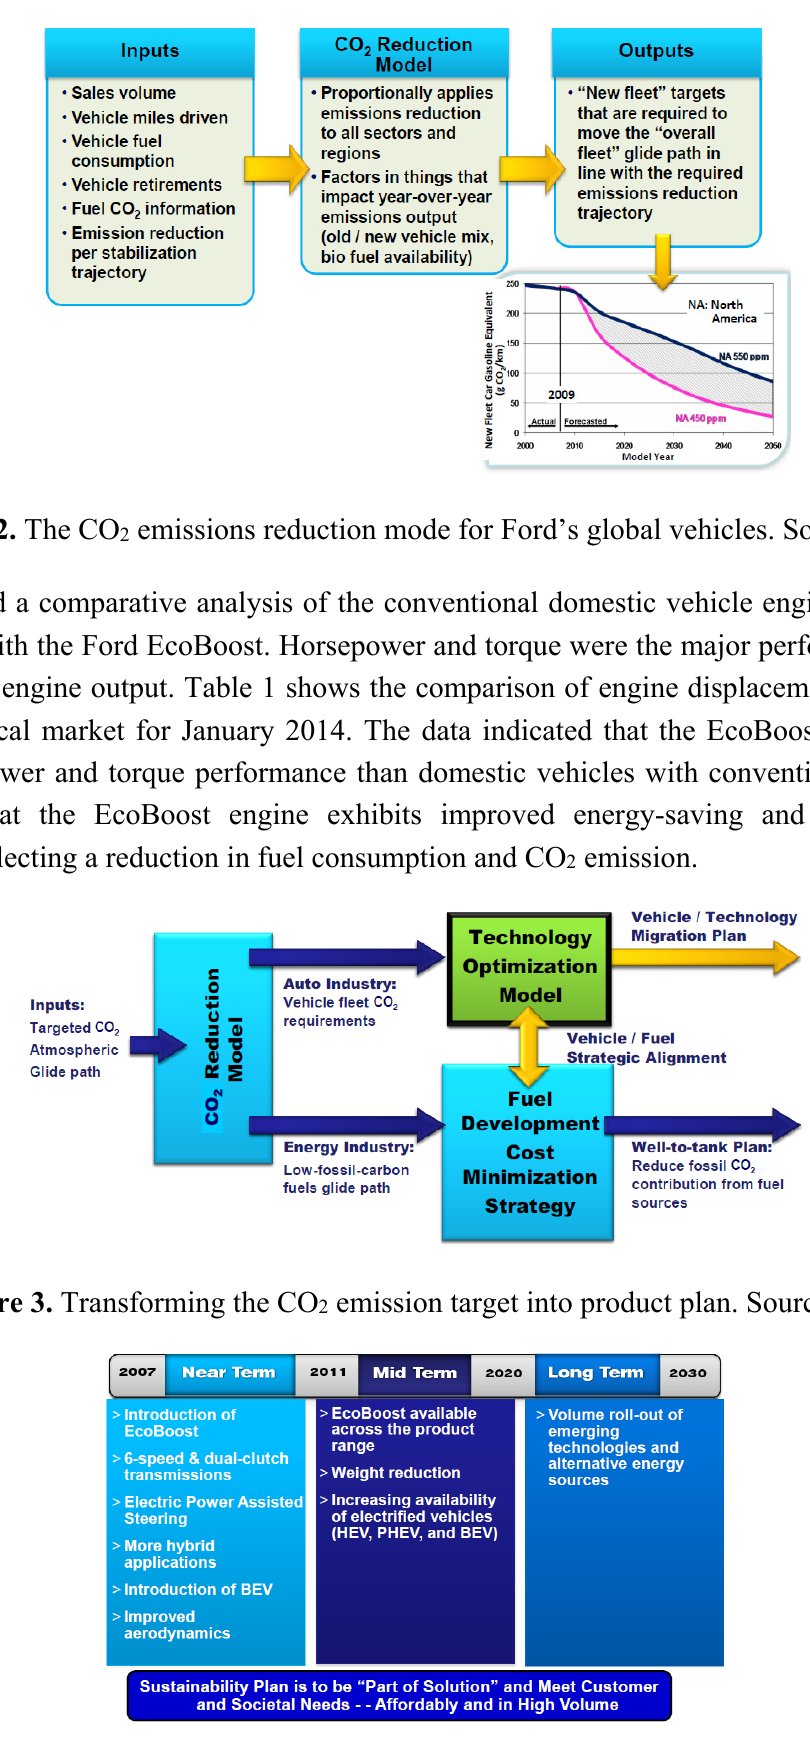
Figure 4. The global sustainability strategy. Source